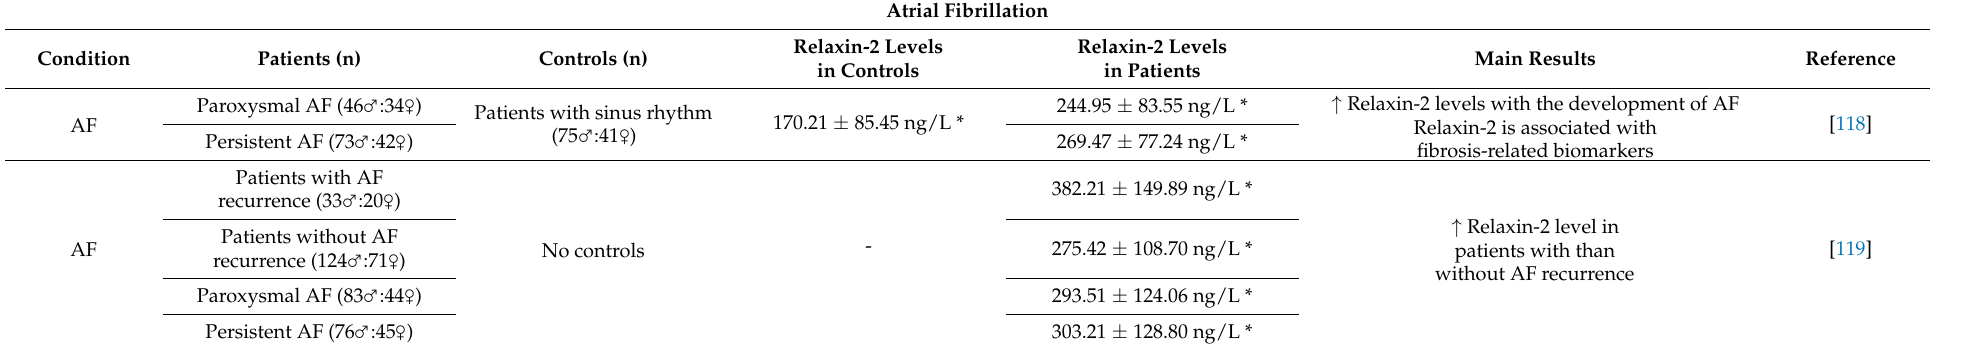
Table 3. Relaxin-2 plasma or serum levels during atrial